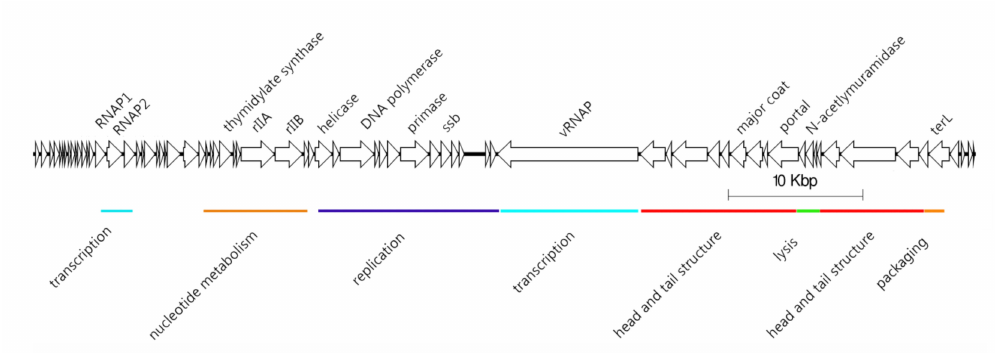
Figure 1. Genome structure of Escherichia phage N4 (70,153 bp) visualized by EasyFig